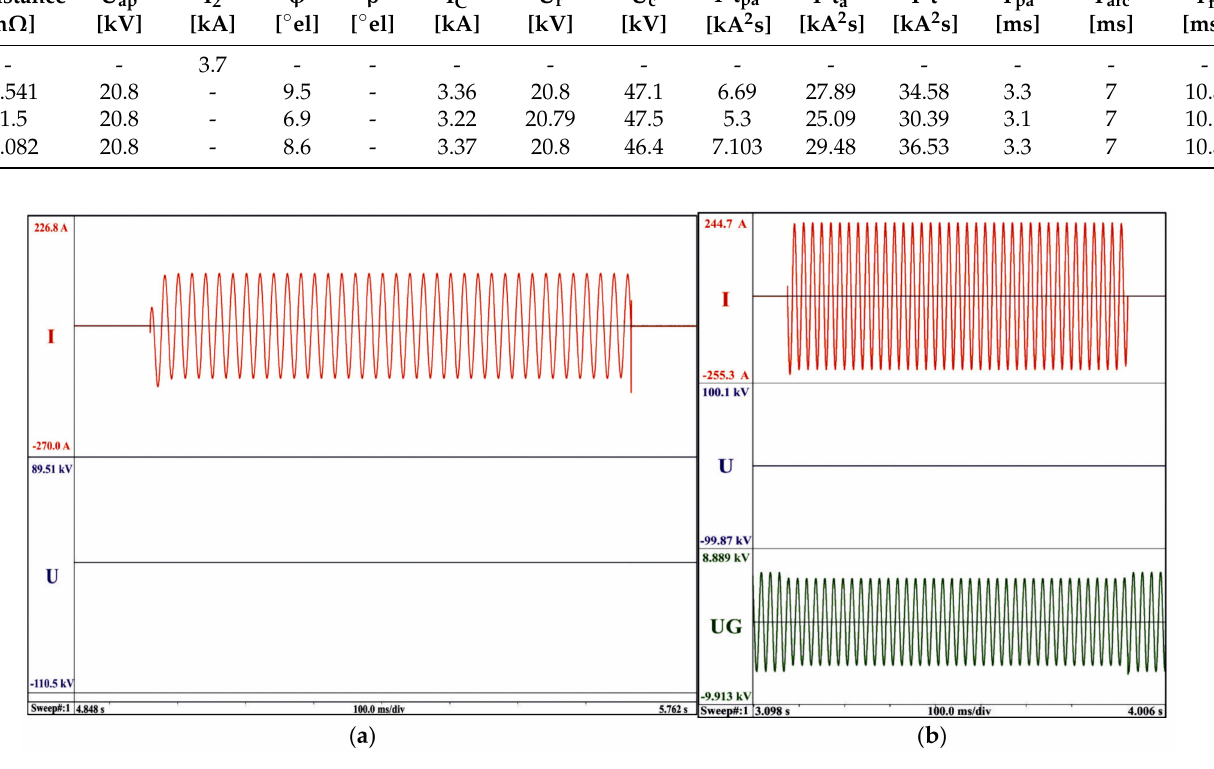
Figure 15. Oscillograms obtained during ( a ) high-voltage calibration and ( b ) low-voltage calibration. After increasing the current I 3 to 190 A, after about 20 s of pre-arcing under the influence of the low-voltage source and switching the high-voltage source at the fuse terminals, there was a correct interruption of the current and recovery of the rated voltage, and the fuse did not blow out in Figure